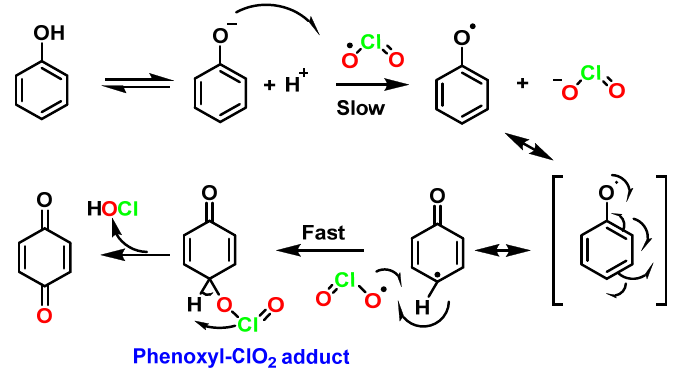
Figure 29. Oxidation of phenols and chlorophenols by reacting with ClO 2 . In red, end products. This is a two ‐ step mechanism: ClO 2 reacts with a phenoxide ion that is stabilized to ClO 2 − and a phenoxy radical. This radical reacts rapidly with a second equivalent of ClO 2 to produce p ‐ benzoquinone and release HOCl. In this mechanism, it was suggested that a phenoxy radical and ClO 2 radical intermediate could be formed[82] (Figure 30).